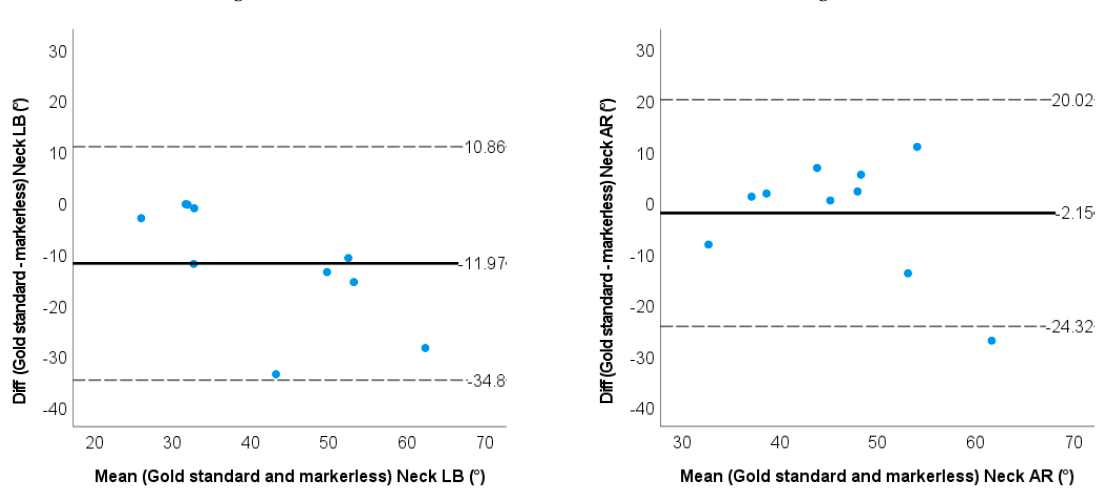
Figure 10. Bland − Altman plots for the ROM of the trunk and neck angle obtained by the gold standard and markerless method for the simulated surgery tasks. The solid line represents the mean difference, and the dashed line represents the 95% limits of agreement.